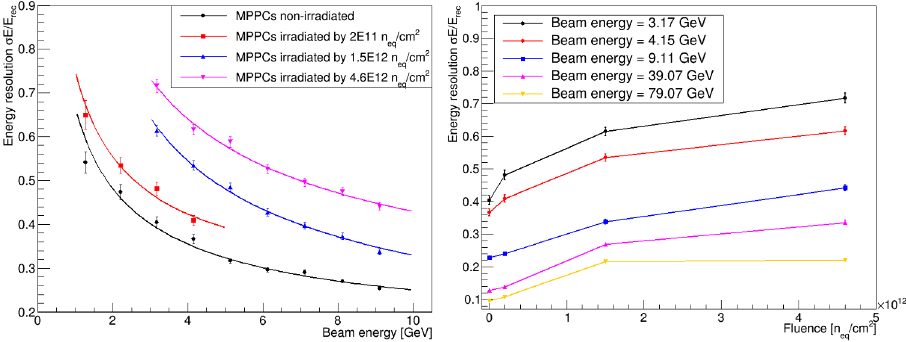
Figure 6. Single module proton energy resolution vs beam energies for di ff erent neutron fluences acquired by MPPCs (left) and vs fluence for di ff erent beam energies